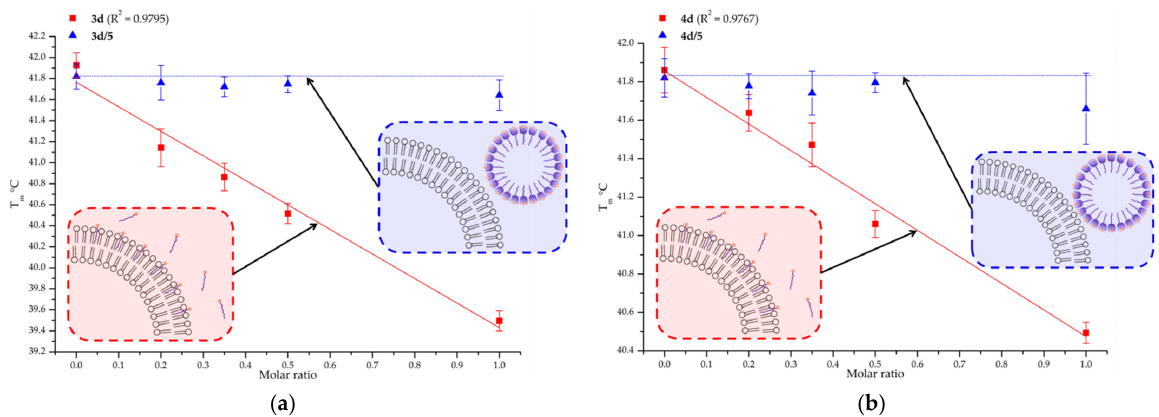
Figure 5. Dependences of the lipid phase transition temperature T m (DPPC) on the amount of 3a ( a ) 4a ( b ) (red) and systems 3a/5 ( a ) 4a/5 ( b ) (blue) at pH = 7.4.